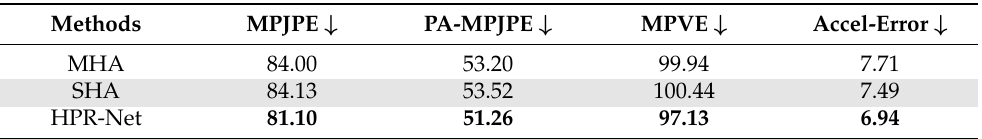
Table 8. Comparison of refinement performance according to network design of HPR-Net. Bold values indicate best